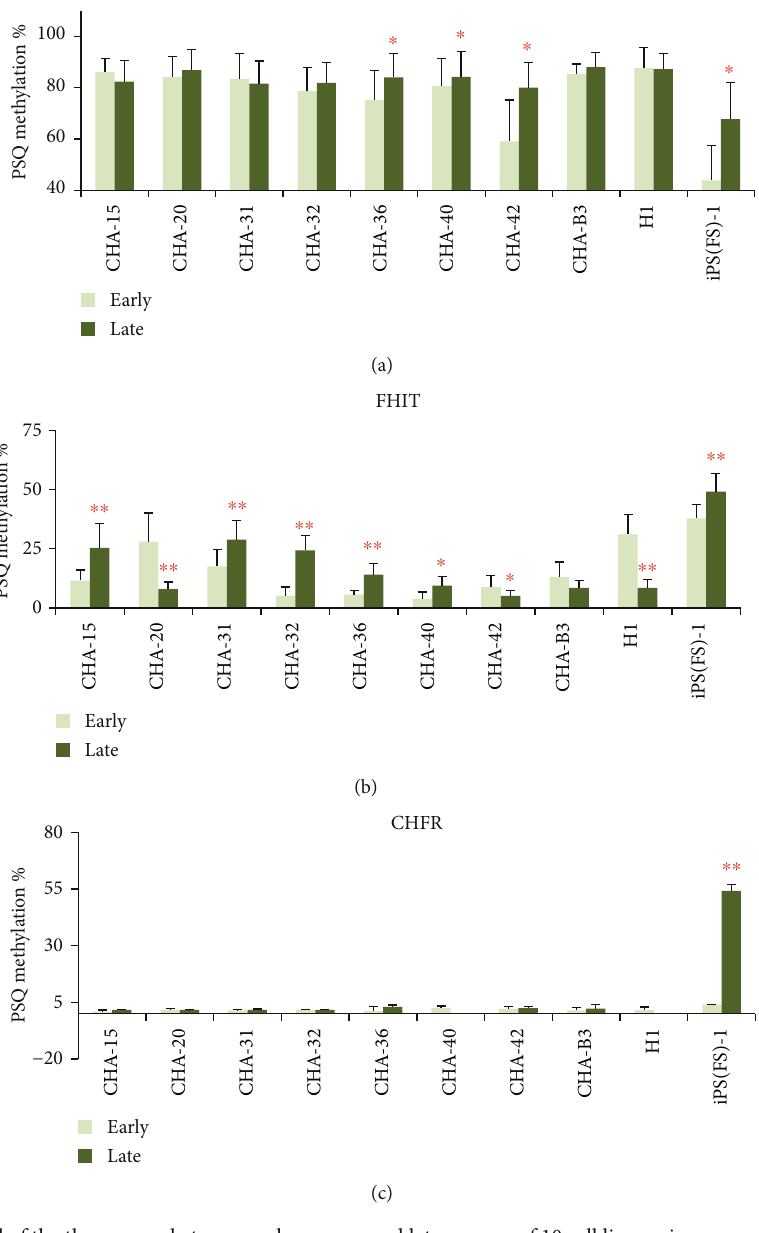
Figure 3: Methylation level of the three genes between early passage and late passage of 10 cell lines using pyrosequencing. PSQ methylation % of the CASP8 gene (a), FHIT gene (b), and CHFR gene